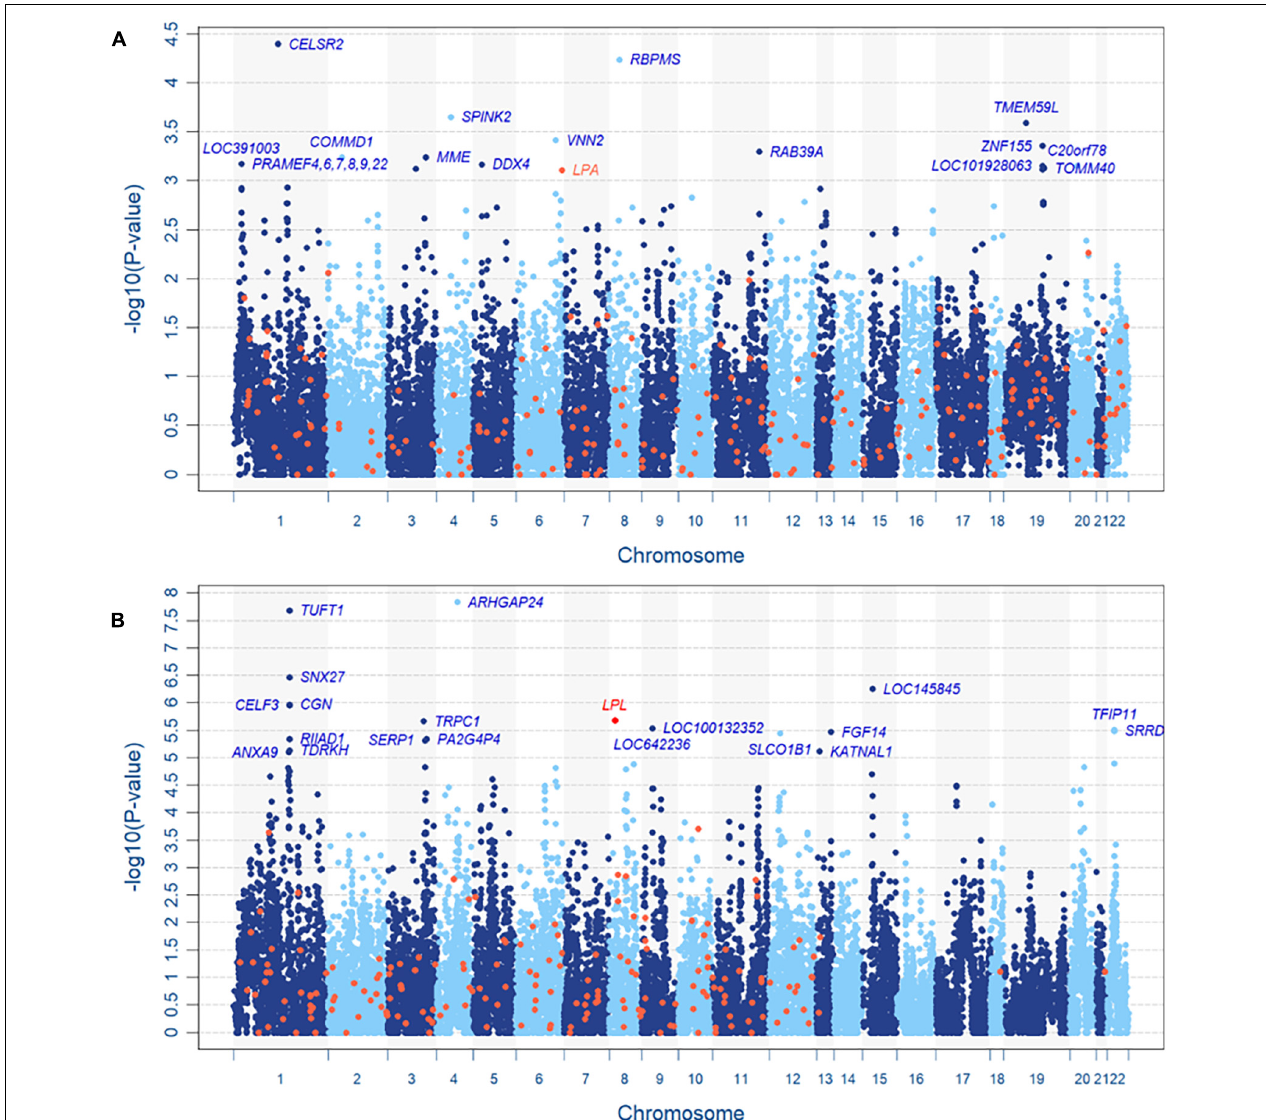
FIGURE 4 | Manhattan plots of TWB, (A) continuous LDL-C level and (B) dichotomized TG level. In panel (A) , LOC391003 , PRAMEF4 , PRAMEF6 , PRAMEF7 , PRAMEF8 , PRAMEF9 and PRAMEF22 share the same copy number segment which contains no